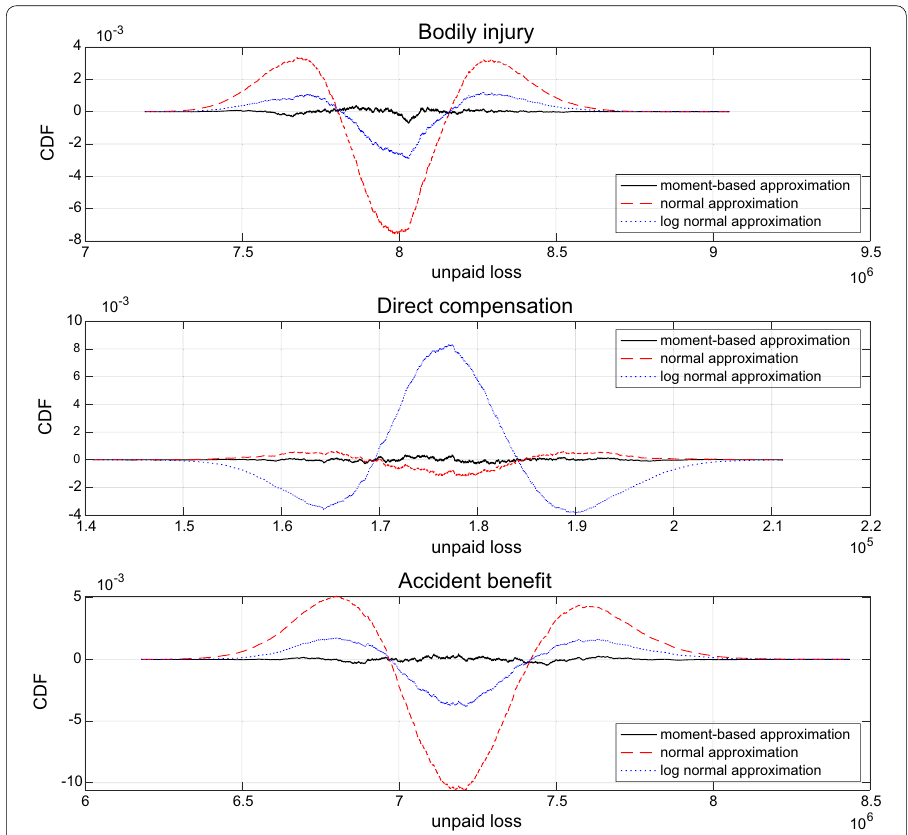
Fig. 4 Differences between the CDFs of approximations and empirical CDF